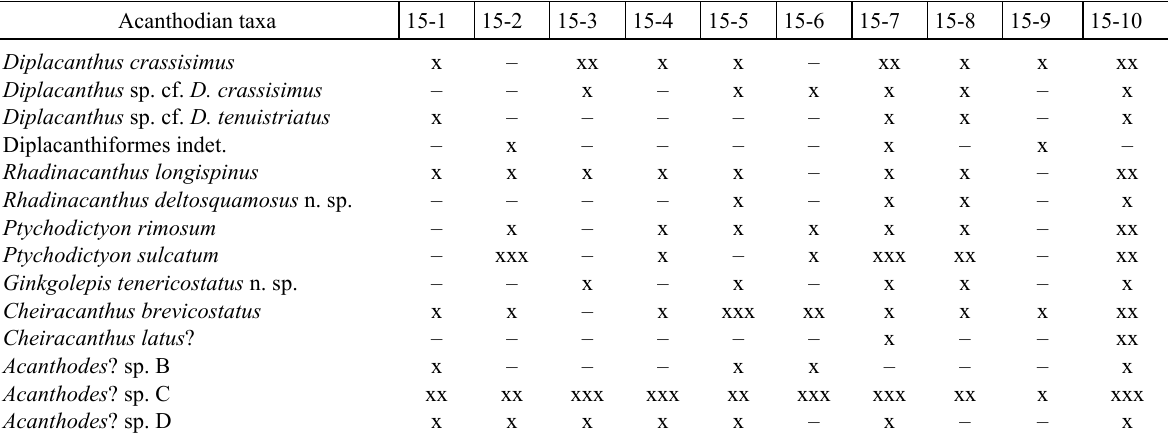
Table 1. The distribution of acanthodian microremains in samples from the Karksi outcrop, taken in 2015. Relative abundance of acanthodian scales: x, low; xx, medium; xxx, high; –, not found